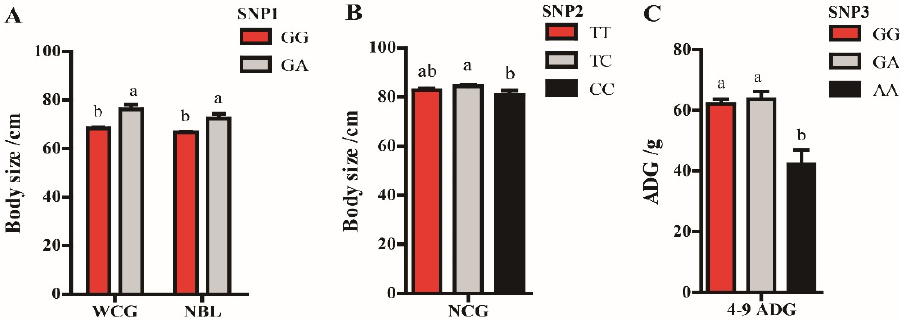
Figure 3. Associations for the SNPs of IGF1 gene with growth traits in Hulun Buir sheep. ( A ) The comparison of growth traits in SNP1 genotypes of IGF1 gene; WCG = chest girth at weaning (4-month-old); NBL = body length at 9-months-old. ( B ) The comparison of growth traits in SNP2 genotypes of IGF1 gene; NCG = chest girth at 9-months-old. ( C ) The comparison of growth traits in SNP3 genotypes of IGF1 gene; 4–9 ADG = average daily gain from 4 to 9-months-old. Different letters (small letters: p < 0.05) above the column indicate significant differences among the different genotypes.